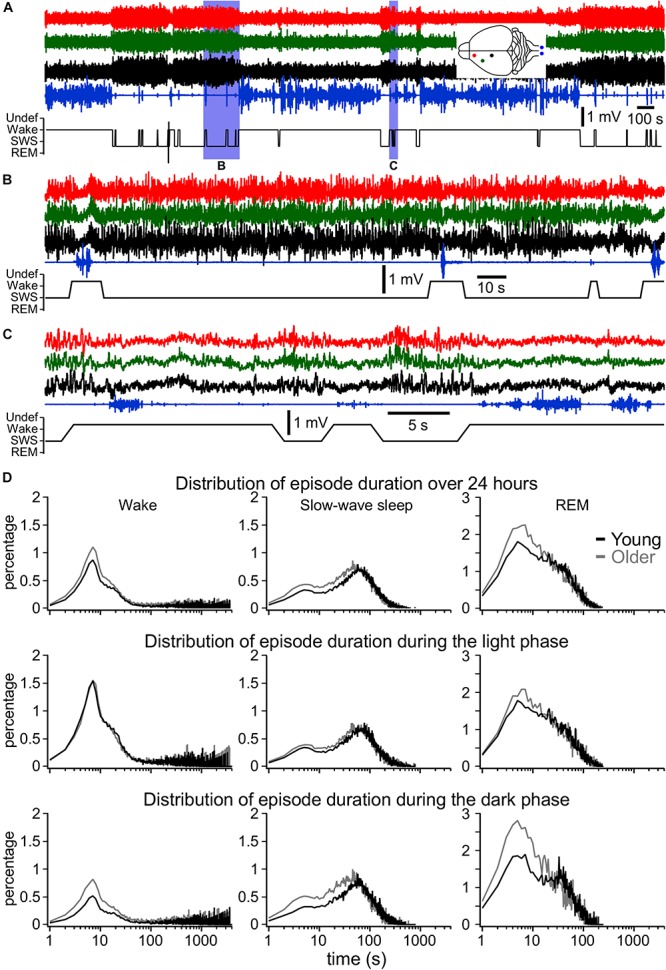
Fragmentation of sleep and wake states. (A) One-hour long LFP recordings at the beginning of the dark phase (19:00–20:00 h) in a 1-year old mouse. (B,C) Expended fragments from this recording demonstrating the presence of very short wake episodes during SWS [activated LFP and increased muscle tone, (B)] and sleep episodes during wake [slow-wave activity and reduced muscle tone, (C)]. (D) Share of all episodes from all investigated animals and days of wake, SWS, and REM sleep of different duration with 1 s resolution for 24 h, for light phase and dark phase as indicated for young and older mice. These distributions show that older mice have larger number of short-lasting states, in particular during the dark phase.